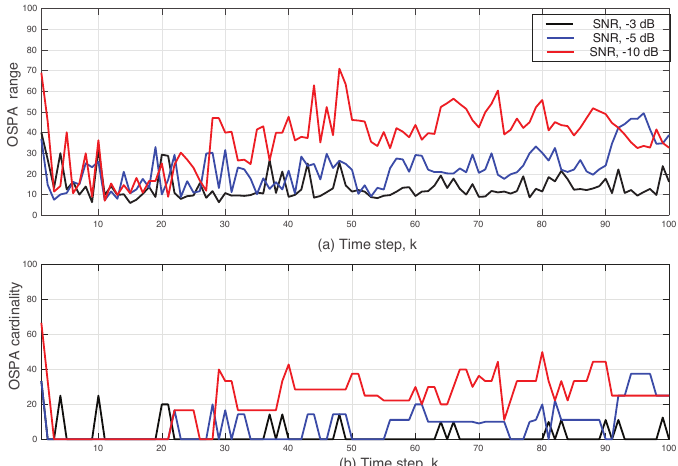
Figure 9. DDP-STP OSPA ( a ) range and ( b ) cardinality for − 3, − 5 and − 10 dB SNR in Experiment 3. Experiment 4. DPY-STP and DDP-STP for tracking multiple objects. As discussed in Section 4, the DPYP is a better match than the DDP when tracking objects with high variability in the scene. This is demonstrated by comparing the new DPY-STP and DDP-STP methods in tracking a maximum number of 10 targets. The simulations used NIW ( 0, 0, 100, I ) for G 0 and Γ ( 1, 0.1 ) for α for both methods. Using empirical Bayes, the DPYP discount parameter value was approximated to d = 0.37 . The increased performance of the DPY-STP is demonstrated by comparing the true and estimated range obtained by the DPY-STP and DDP-STP in Figure 10. The increased performance is attributed to the increased flexibility of the DPYP in dynamically selecting clusters with a large time-varying number of objects moving in the tracking scene. We also demonstrate this using the OSPA metric with cut-off c = 100 and order p = 1 . We observe that DPY-STP has a better performance compared to DDP-STP as depicted in Figure